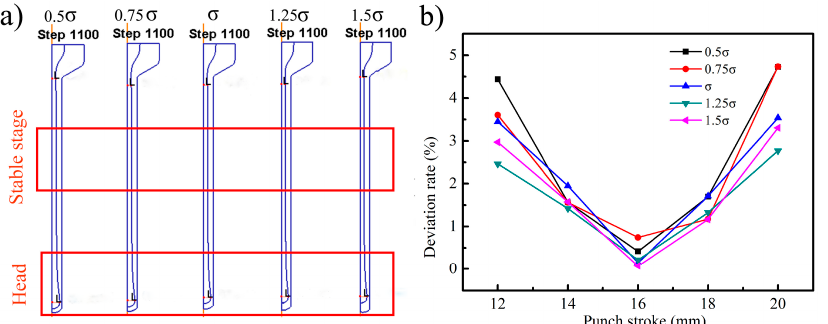
Figure 3. The simulation result of extrusion process of TiBw/Ti6Al4V composite tube with the different filler materials: ( a ) the extrusion result; ( b ) deviation rate of thickness.